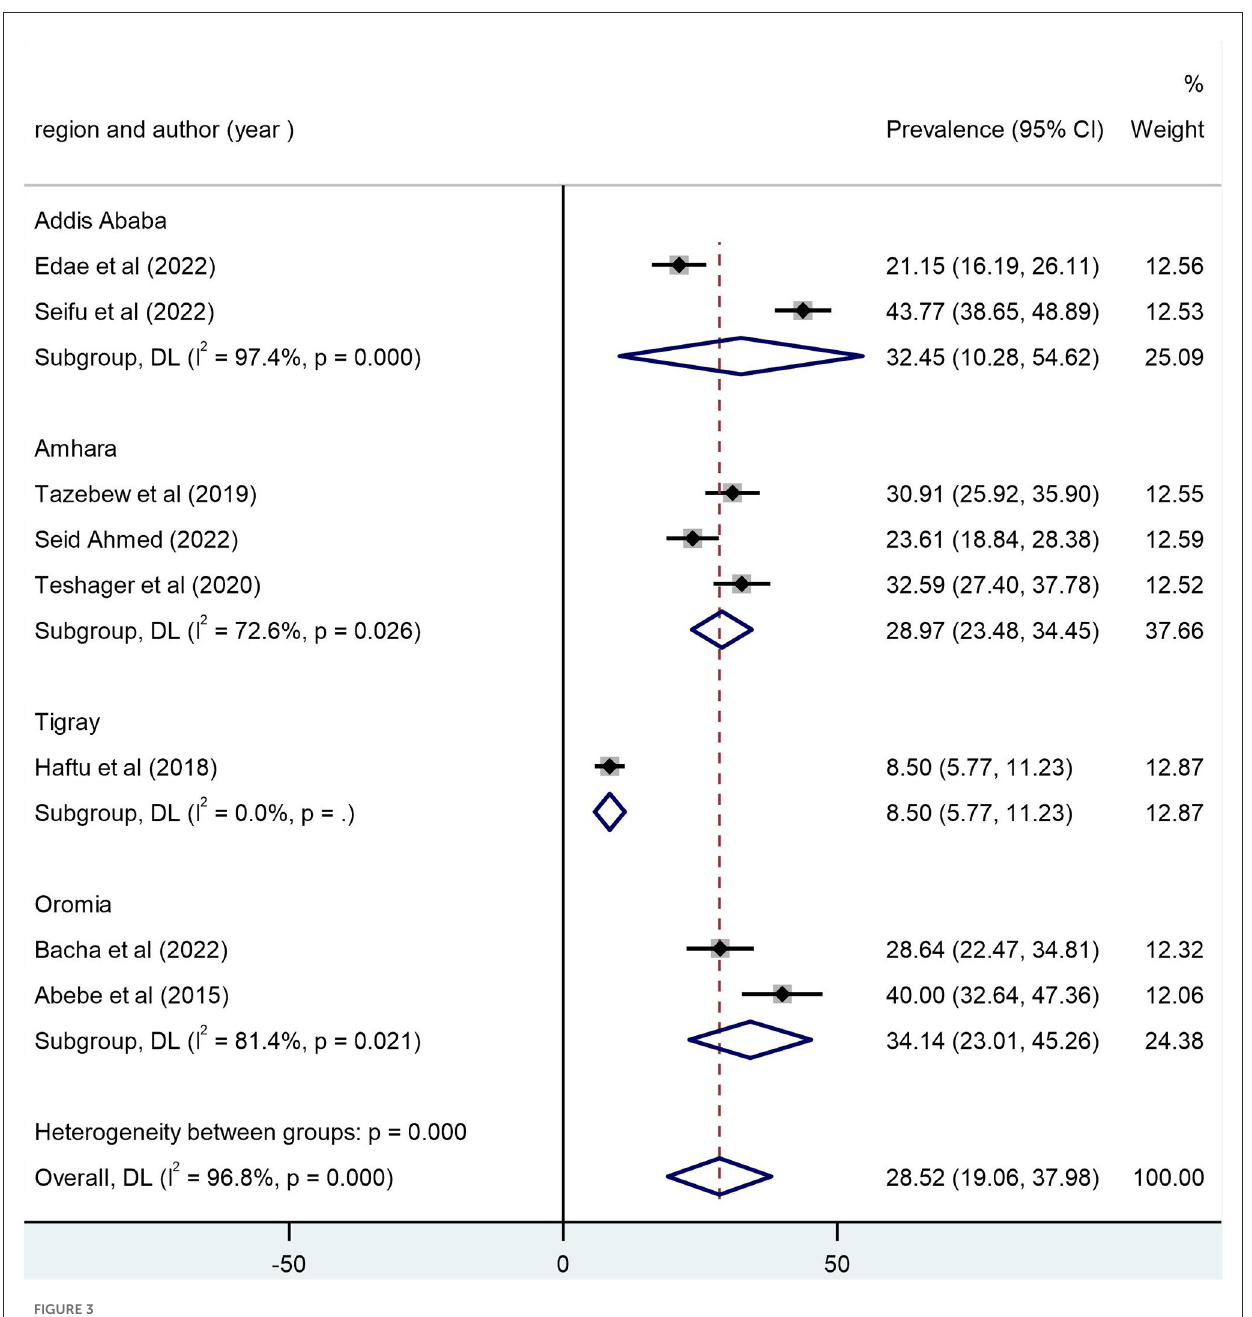
FIGURE3 Subgroup analysis by sample size and